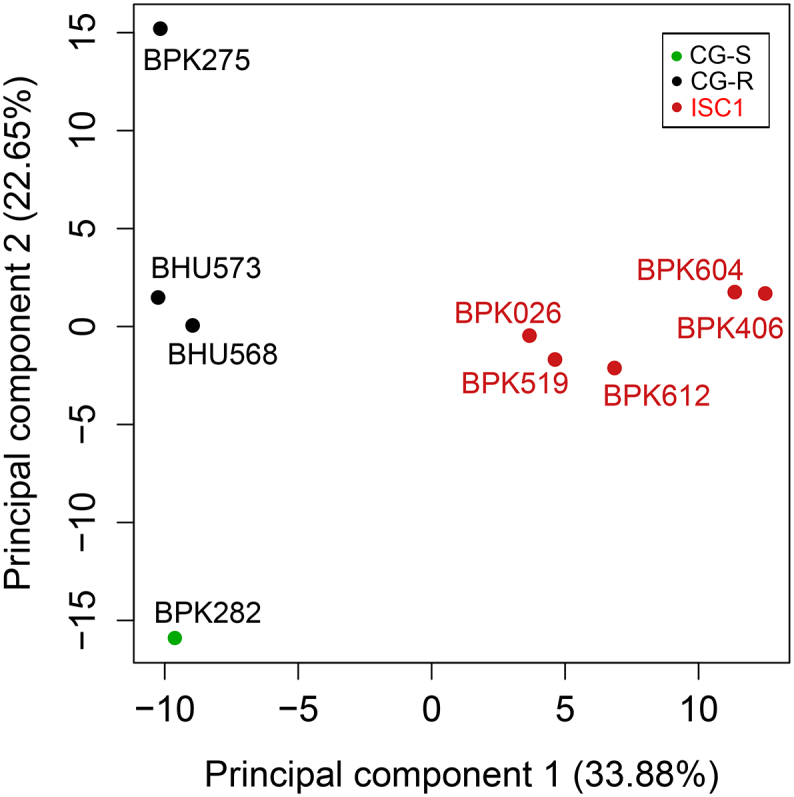
Principal component analysis of the metabolic profiles of the 5 Leishmania donovani ISC1 isolates and 4 CG strains in this study. This analysis was based on the quantitative measurements of all 290 putatively identified metabolites. In this PCA plot, average values are shown for each strain based on four biological replicates. For each principal component, the proportion of variation of the total dataset it explains is mentioned.